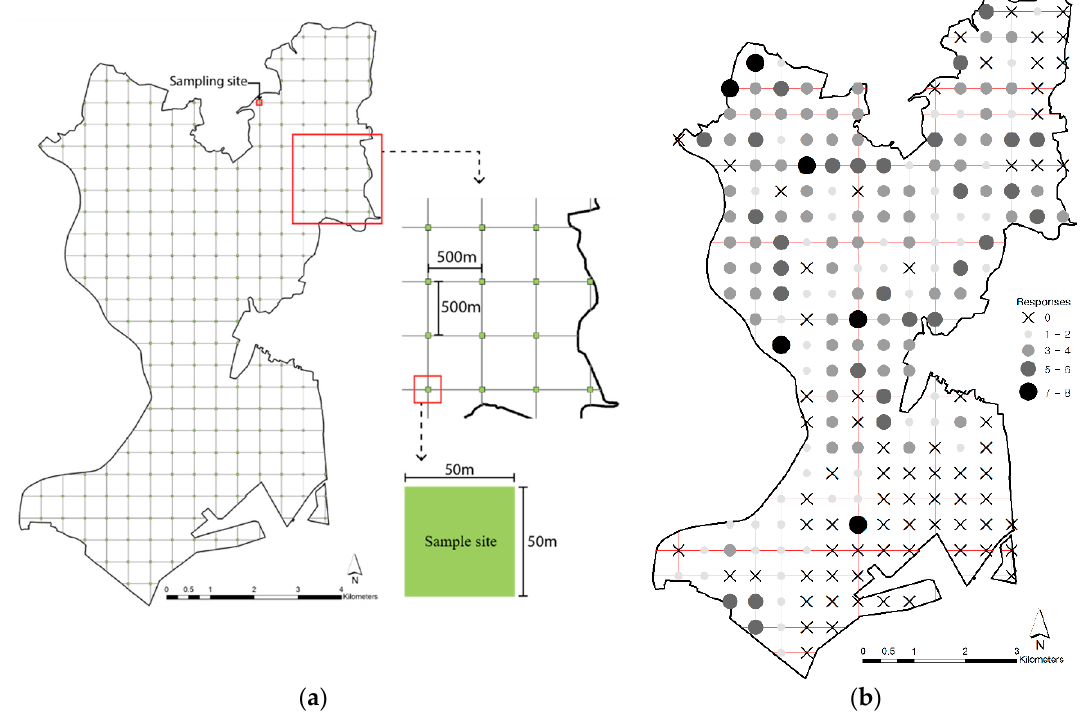
Figure 2. Sampling strategy and number of responses: ( a ) Distribution of survey sites across Ichikawa; ( b ) number of responses per sample site.